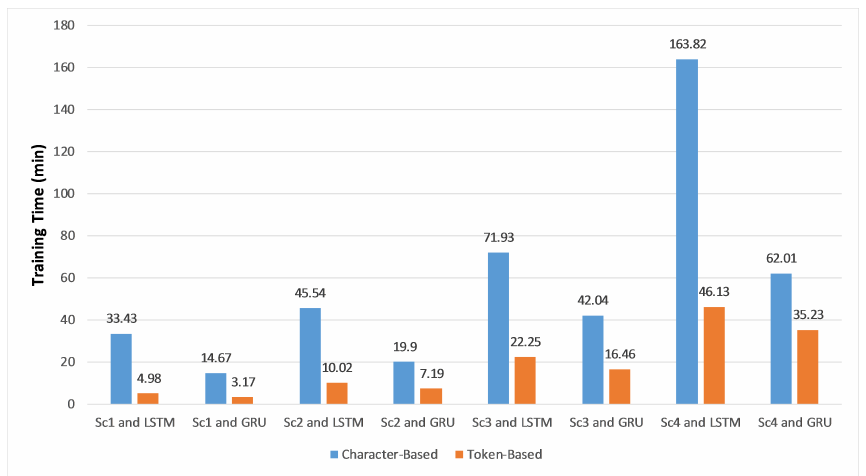
Figure 5. Training times of the proposed approach on a GPU system using character-based and token-based feature extraction.